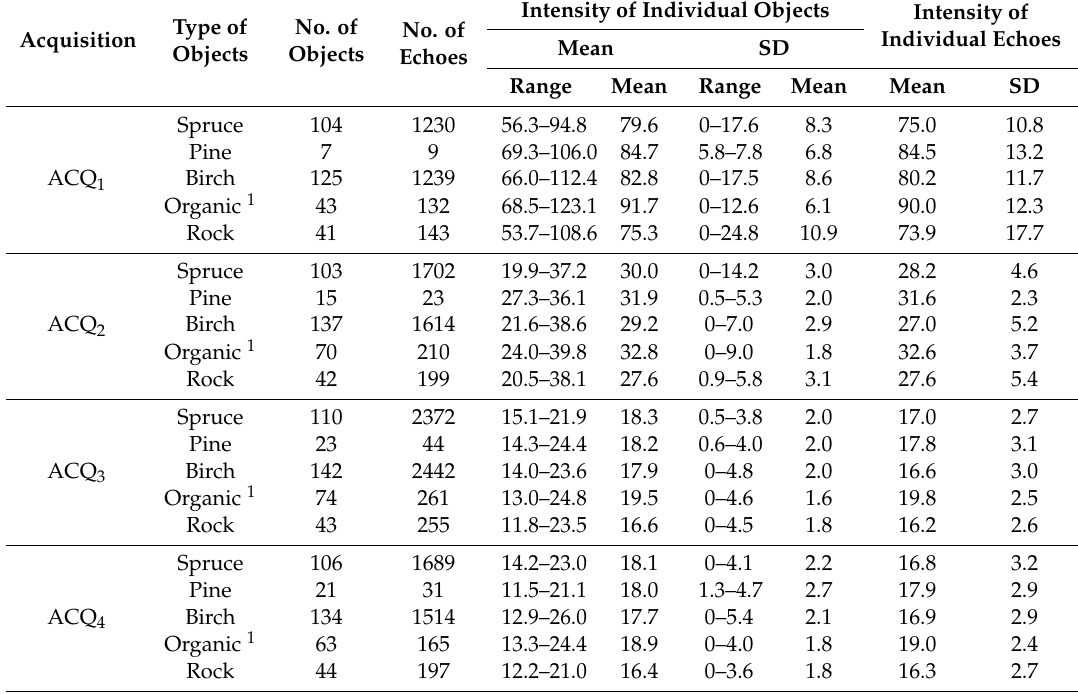
Table 4. Range-normalized intensity values for individual trees and non-tree objects (for echoes with h > 0) and for those individual echoes of each tree and non-tree object with h = h max ( h max > 0). Only objects with at least one echo with h > 0 are included.